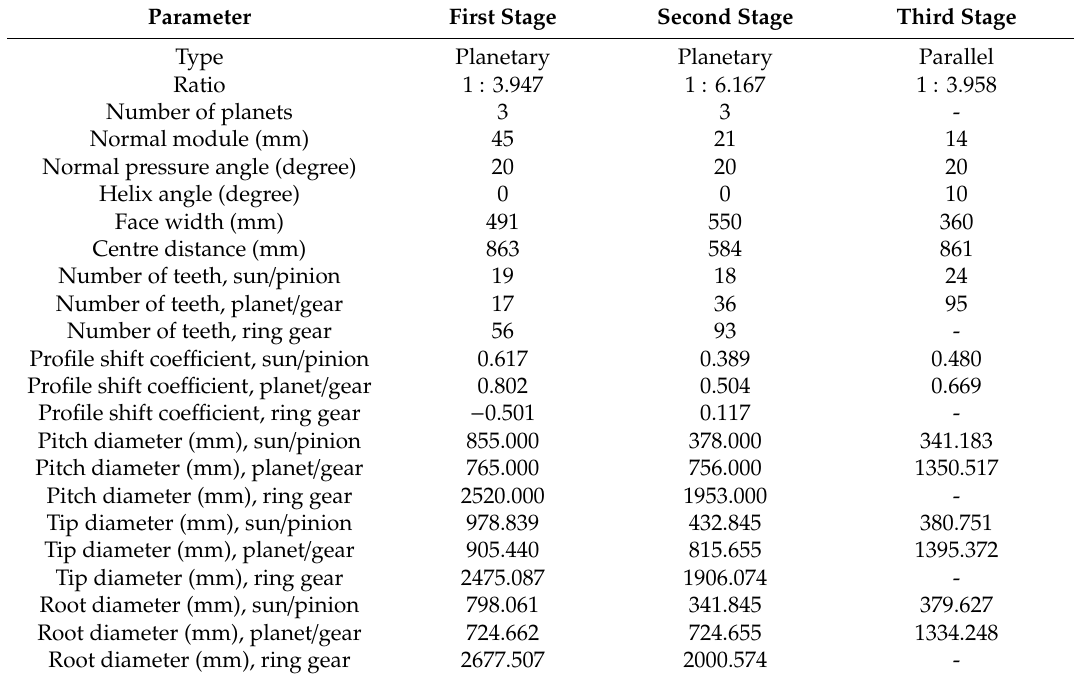
Table 2. Geometric parameters of gearbox for the National Renewable Energy Laboratory (NREL) 5 MW wind